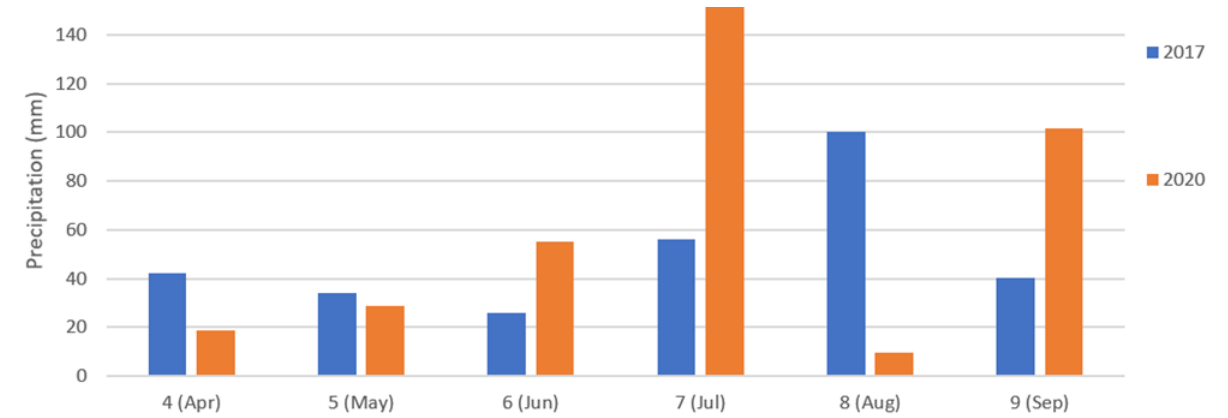
Figure A1. Monthly precipitation, provided by the Finnish meteorological Institute (FMI), from the nearest weather station to research fields l1 and l2 (Oulusalo, Pellonpää). Data were visualized from the main growing season (April – September) during the years of drone data collection (2017 and 2020).